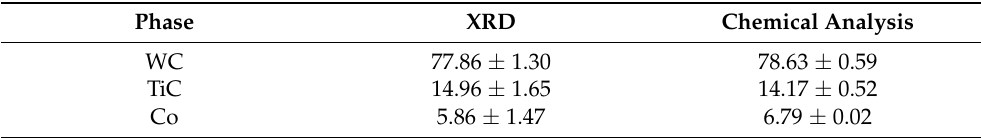
Table 4. Phase compositions of carbide T15K6 (%).